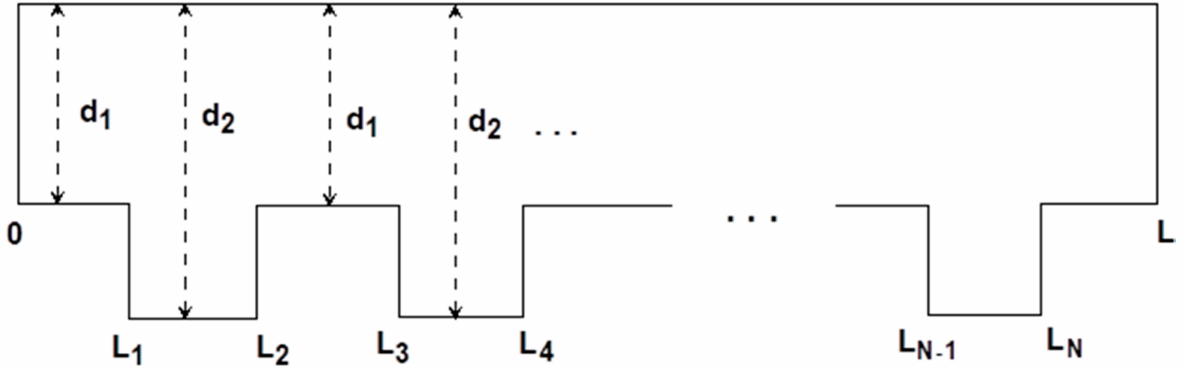
Figure 6. The water channel geometry with the crevasse-ridden bottom, which is considered in the Sturm–Liouville Eigenvalue Problem (4). The channel length L = 16 km. The water-layer depth h 1 = 100